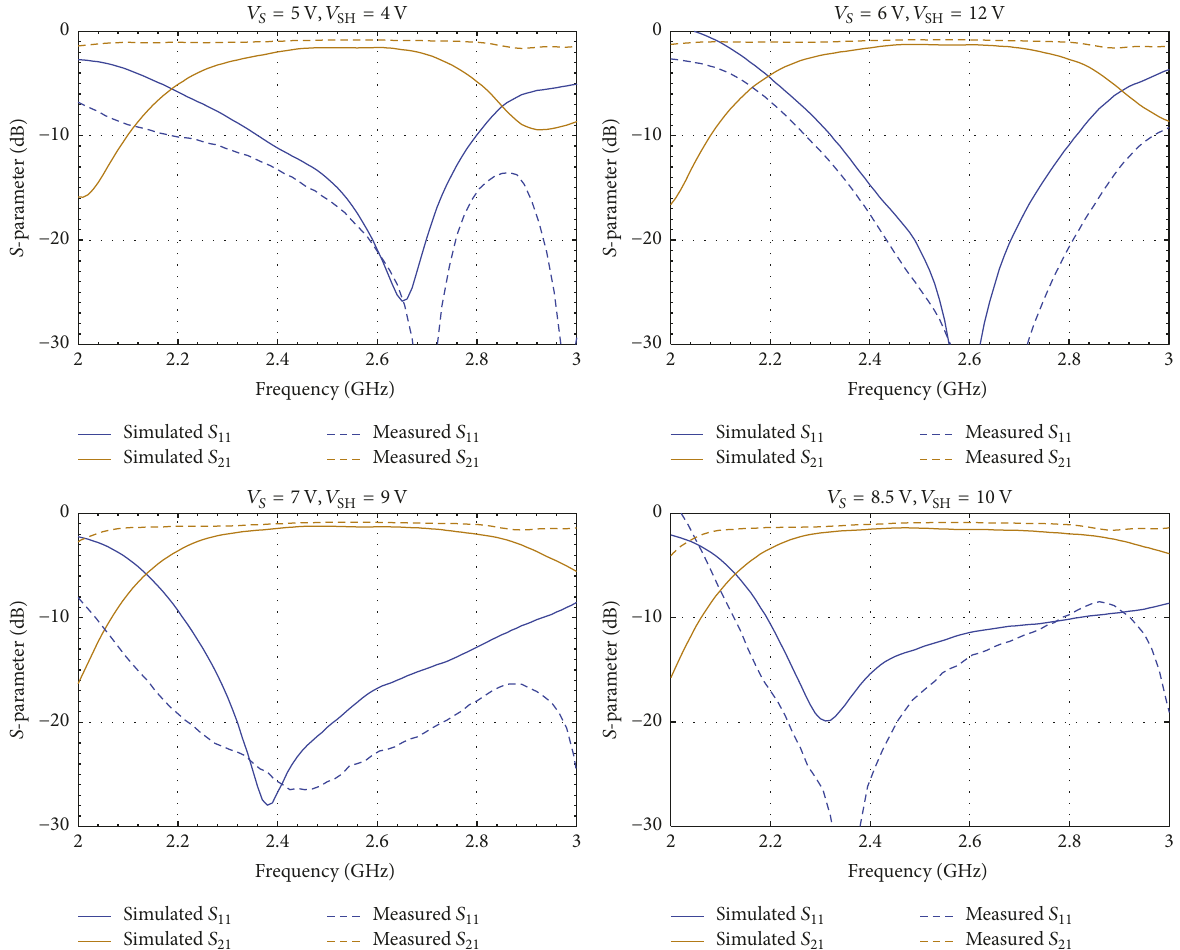
Figure 6: Simulated and measured 𝑆 -parameters for four different configurations. While 𝑉 𝑆 acts as major controller for the center frequency, 𝑉 SH allows for fine-tuning and improvement of the impedance.